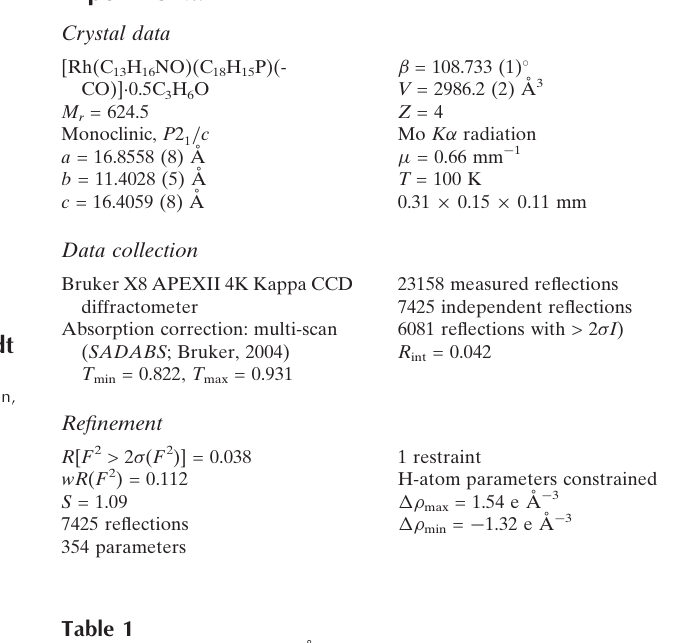
Hydrogen-bond geometry (A˚ , (cid:3) ).